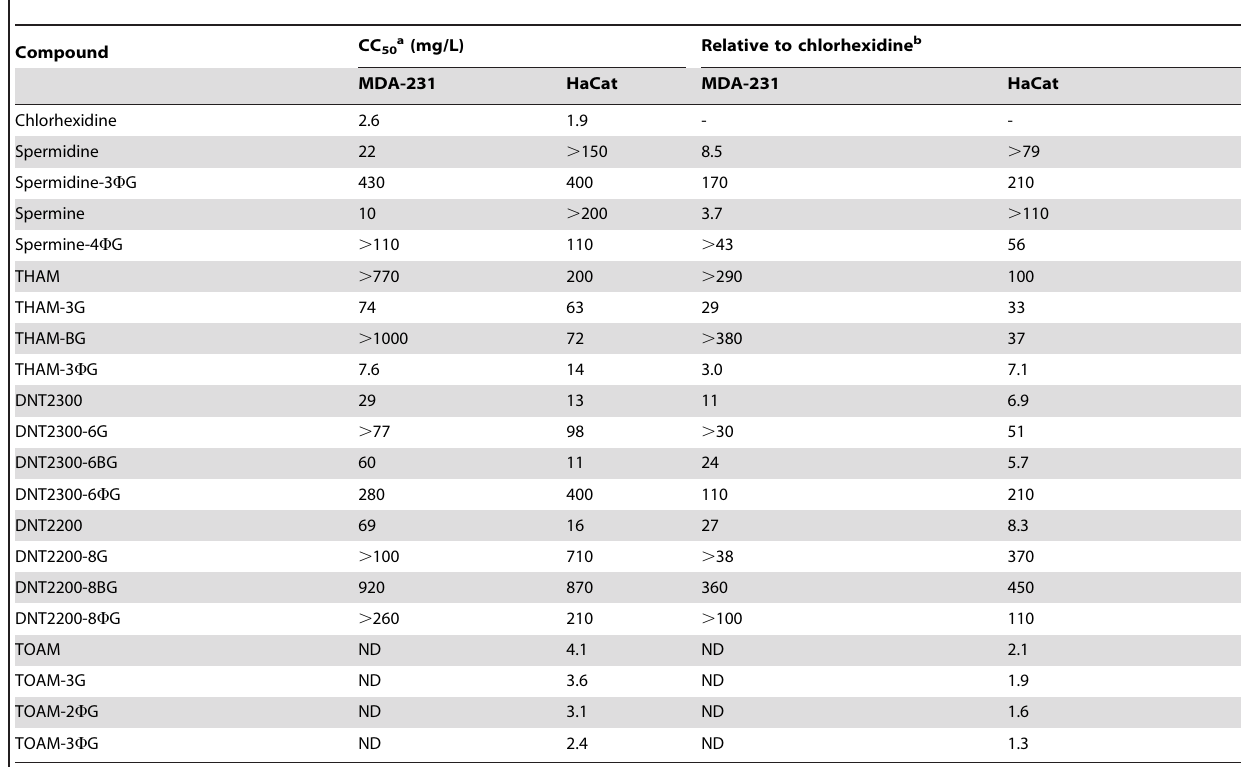
Table 3. Cytotoxicities of the guanide, biguanide, phenylguanide derivatives, and the parent amines, against a human breast